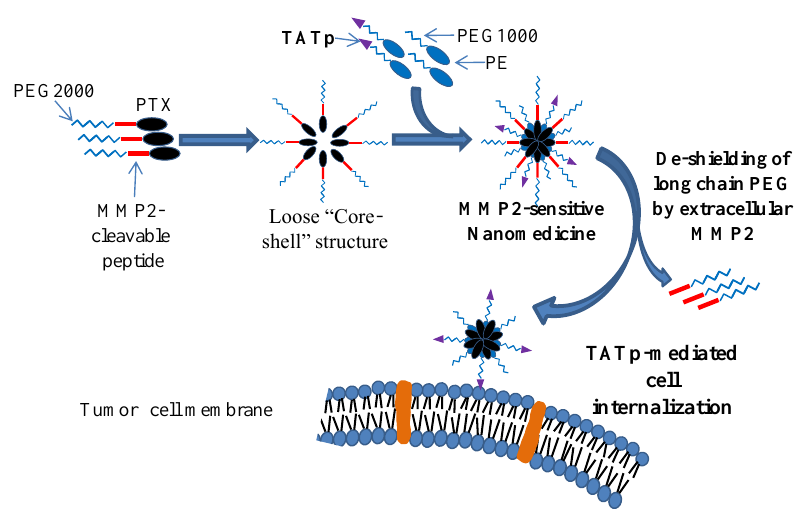
Figure 2. Drug delivery strategy of the MMP2-sensitive self-assembled PTX nanopreparation. The PEG2000-substrate peptide-PTX conjugate self-assembles into loose micelles which are stabilized by lipids harboring TAT. Whereas TAT is buried by longer PEG layers in the circulation, cleavage of the substrate by tumor-secreted MMP2 leads to TAT-mediated cellular internalization for anticancer therapy. Reproduced with permission from [19].